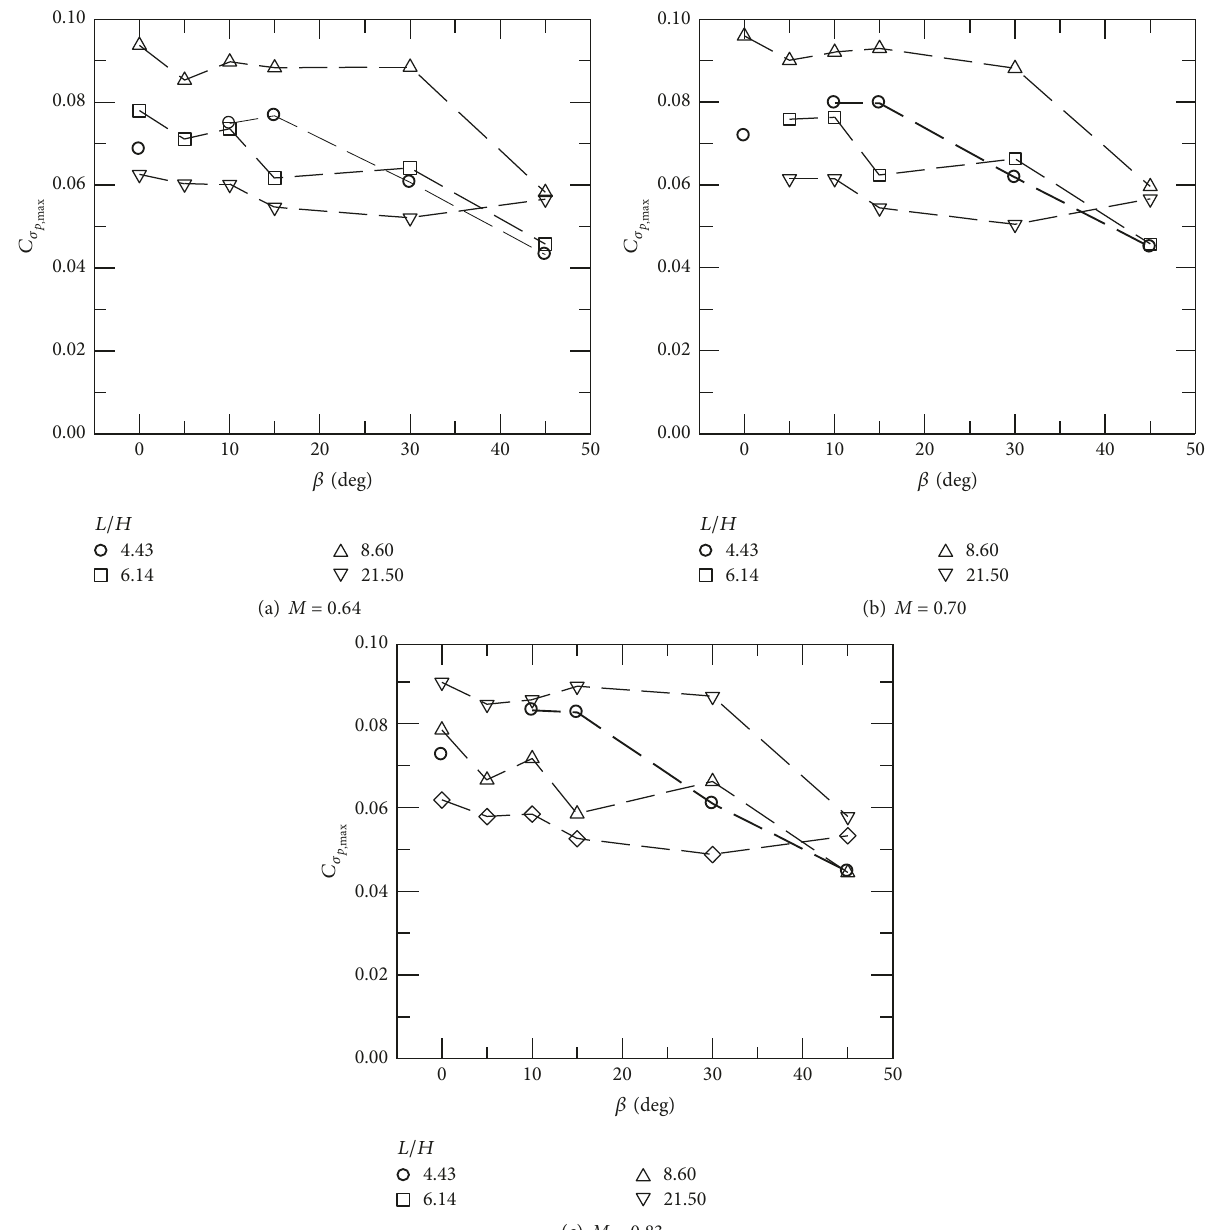
Figure 8: Peak pressure fluctuations: (a) M = 0.64, (b) M = 0.70, and (c) M =